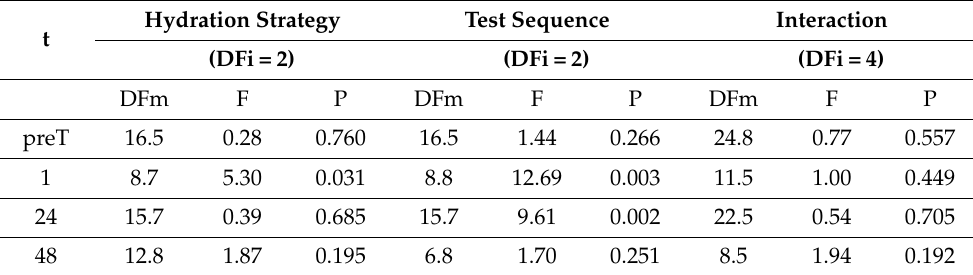
Table 8. Results of analysis of variance for myoglobin measured before the test (preT) and 1, 24, and 48 h after the exercise test: significance of (P) and F-statistic along with the number of degrees of freedom (DFi—in the numerator; DFm—in the denominator) for the fixed effects (hydration strategy, test sequence, and their interaction).